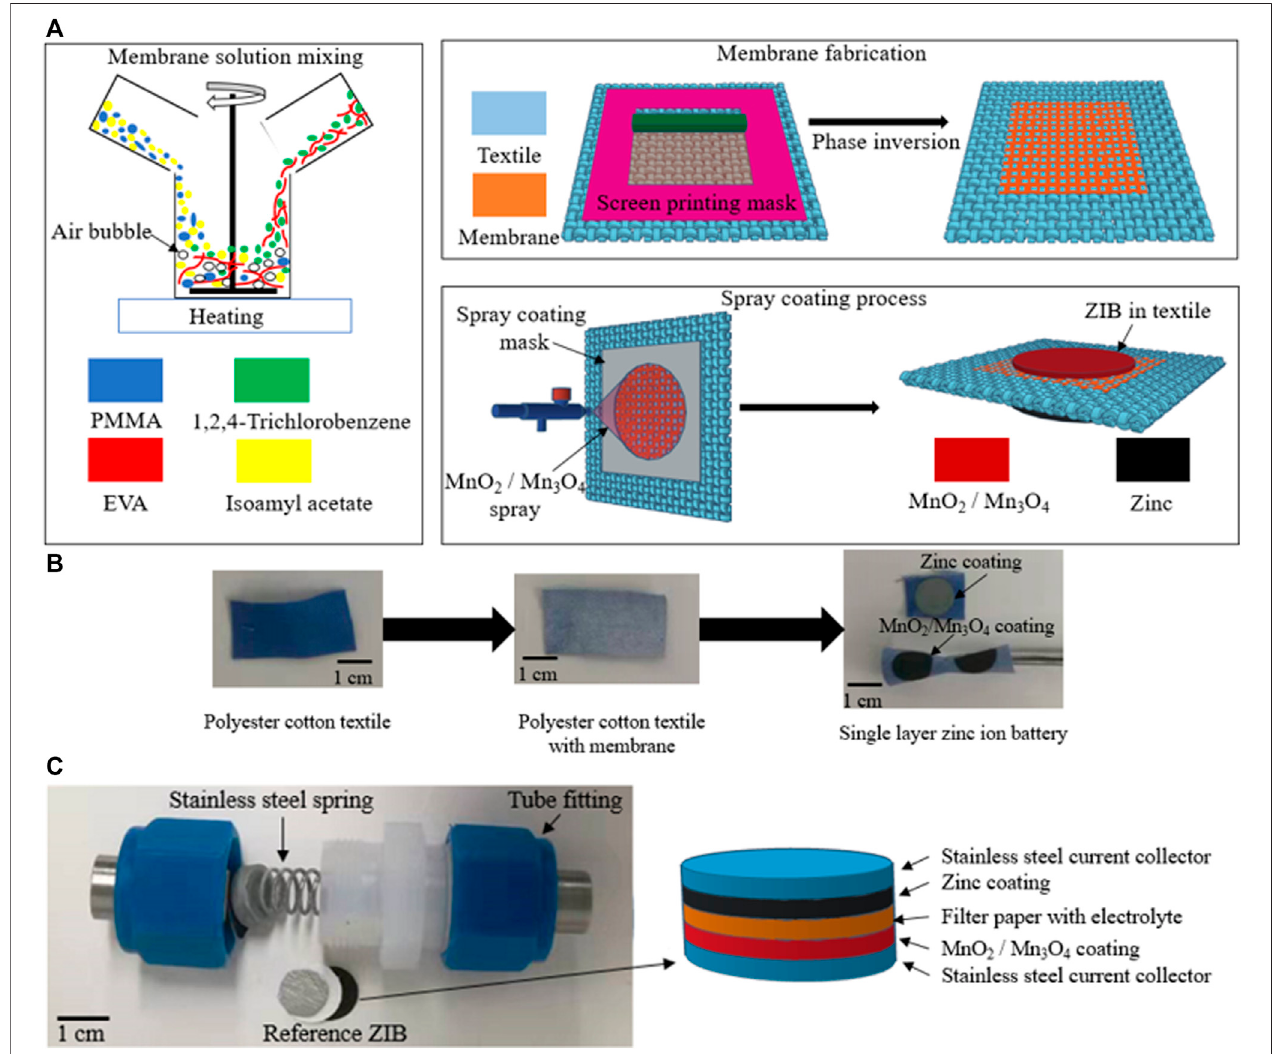
FIGURE 1 | (A) Schematic of fabrication process. (B) of plain-woven textile, the textile with membrane, and single layer zinc ion battery. (C) Test set up and the schematic of reference ZIB with MnO 2 and Mn 3 O 4 cathode.